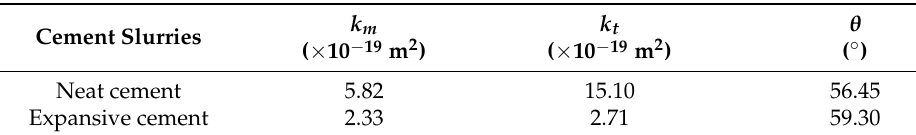
Table 2. Verified results of breakthrough pressure.